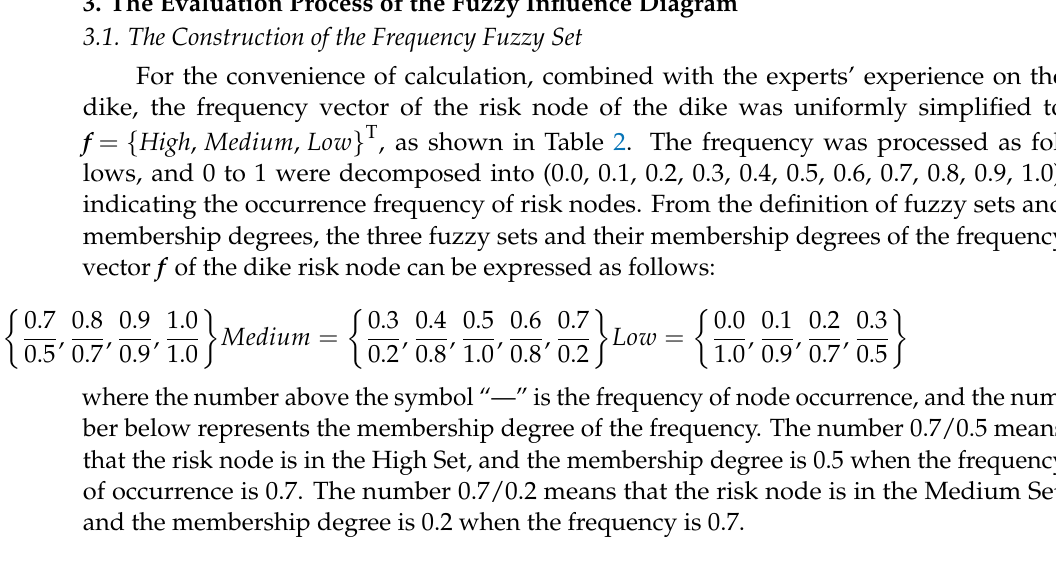
Table 2. The state and frequency of risk